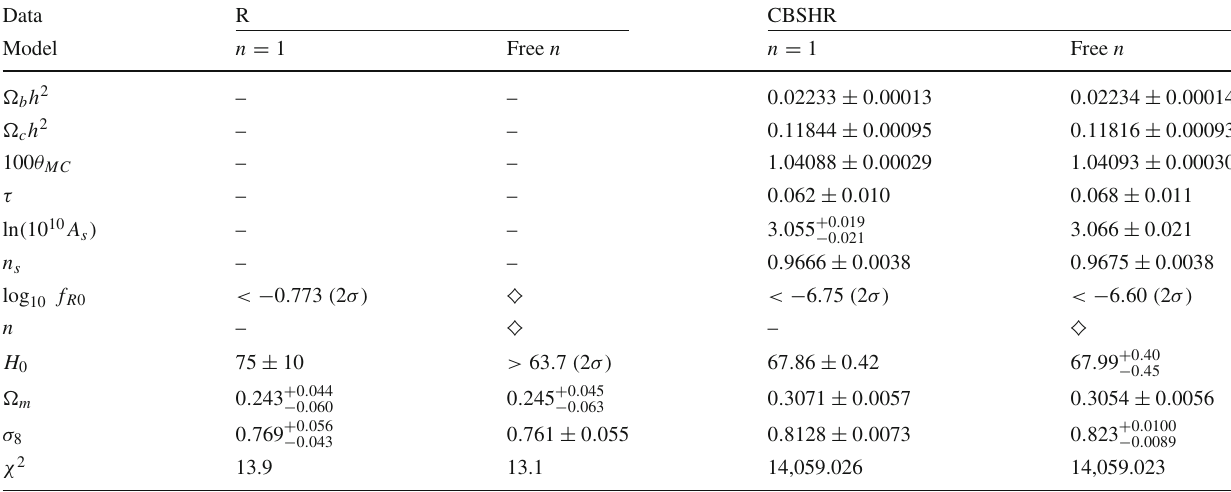
Table 2 The marginalized constraints on the HS f ( R ) models with n = 1 and free n are shown by using the “R” and “CBSHR” datasets, respectively. Similarly, for the typical parameter log 10 f R 0 , we quote